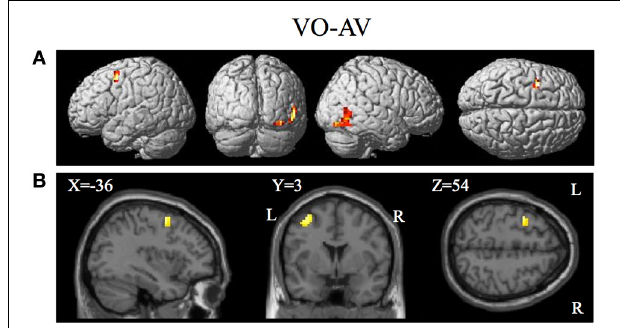
FIGURE 8 | Brain activity significantly active for the contrast of visual only VO relative to the combined AV conditions thresholded at p < 0 . 001 uncorrected. Activity was present in the left PMvs/PMd and the left MT/V5 visual motion processing area. (A) Activity rendered on the surface of the left, back, right, and top of the brain. (B) Section through brain taken at MNI coordinate − 36, 3, 54 shows activity that was present in the PMvs/PMd region. L, left side of brain; R, right side of brain.